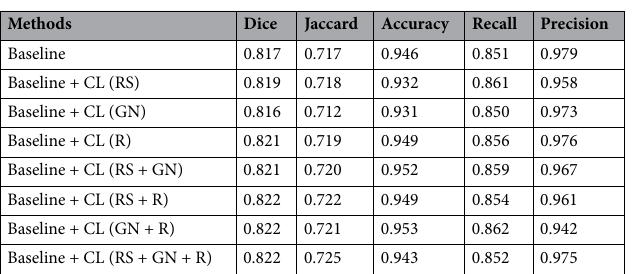
Methods Dice Jaccard Accuracy Recall